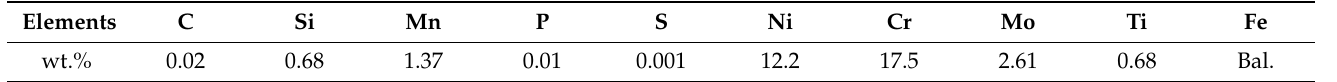
Table 1. Chemical composition (wt.%) of 316L SS used in the